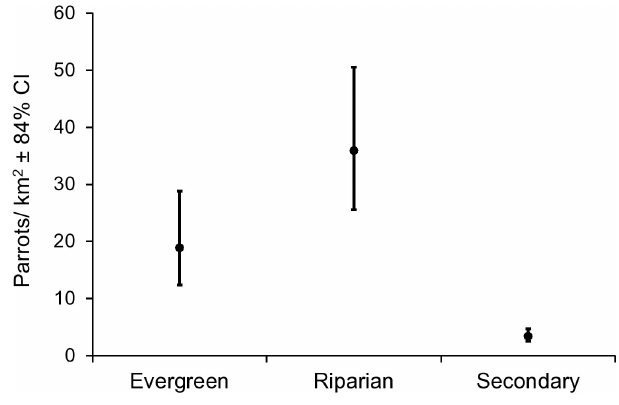
Fig. 2 . Northern Mealy Amazon ( Amazona guatemalae ) density estimates with 84% confidence intervals in evergreen, riparian, and secondary tropical moist forest in Los Chimalapas, Mexico, during the breeding season of March 2014.